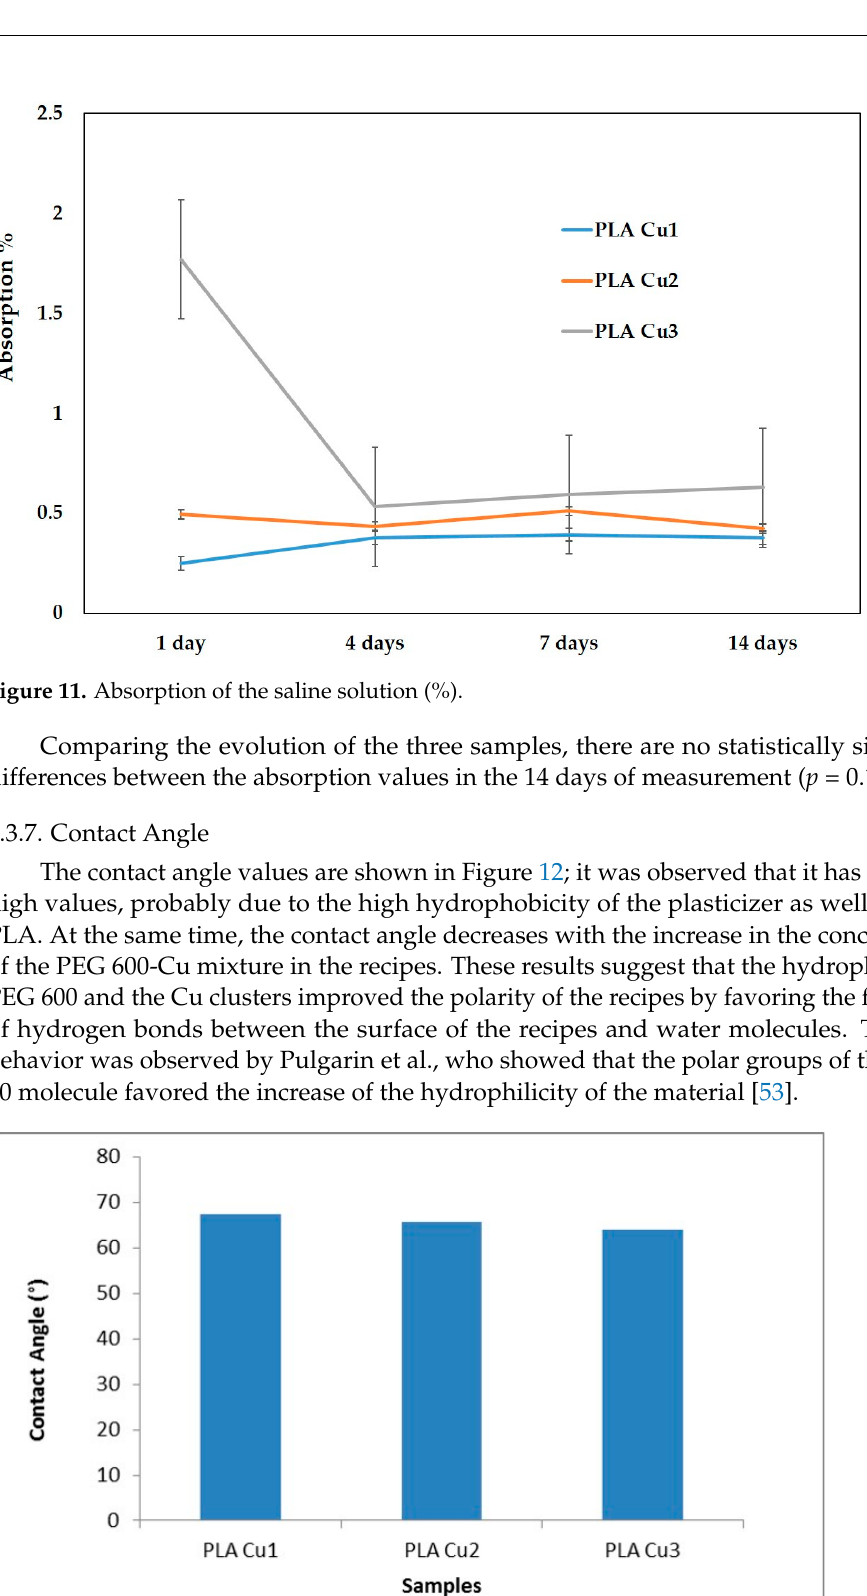
Figure 13. SEM image × 5000 magnification on the PLA-Cu1 sample surface. 3.3.9. Antimicrobial Activity After the end of the incubation period, at 37 °C, the zones of inhibition (mm) were determined for the tested microbial strains. It was observed that in all the tested samples,